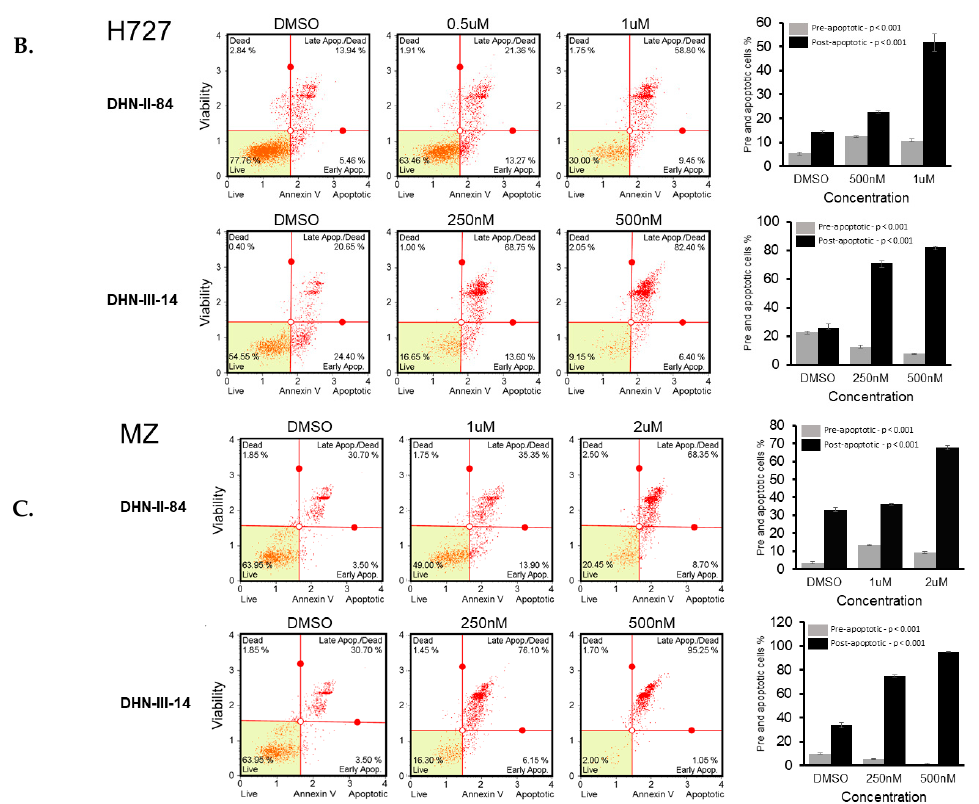
Figure 5. DHN-II-84 and DHN-III-14 increase apoptosis in neuroendocrine cancer cells. BON ( A ), H727 ( B ) and MZ-CRC-1 ( C ) cell lines were treated with increasing doses of DHN-II-84 and DNH-III-14, with half-maximum inhibitory concentration being the highest dose. A dose-dependent increase in apoptosis was observed in all cell lines. The highest response to the drug treatment was seen in MZ-CRC-1 when treated with DHN-III-14 ( C ), and the lowest response was seen with BON treated with DHN-II-14 ( A ). Bar graphs represent the mean of pre- and post-apoptotic cells ± SEM. Measurements were performed in triplicates. Statistical differences of pre- and post-apoptotic cells after treatment were determined by one-way ANOVA.